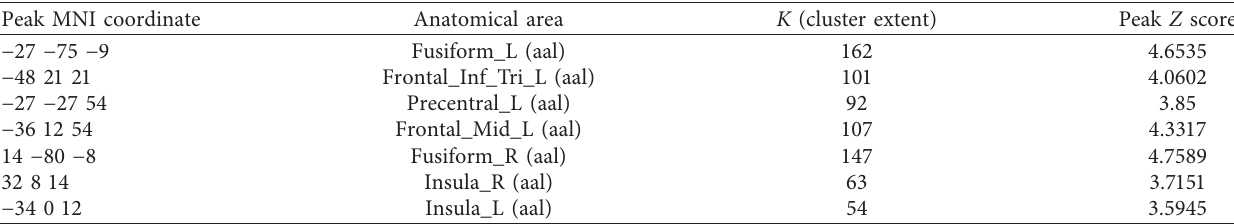
Table 2: Regions of P300 FMRI activation to the targets.